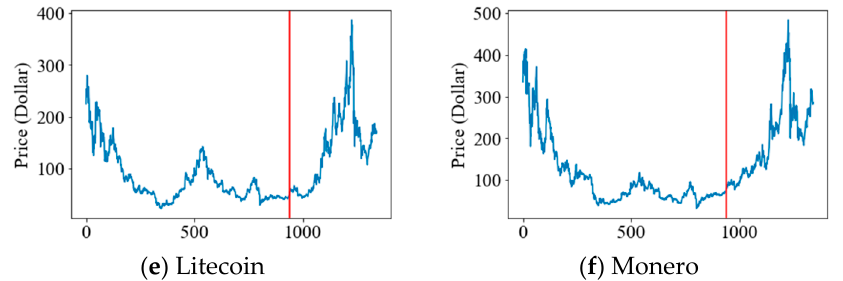
Figure 6. Price fluctuation graph of 6 major cryptocurrencies per each day. ( a ) Bitcoin; ( b ) Cardano; ( c ) Dash; ( d ) Ethereum; ( e ) Litecoin; ( f ) Monero.